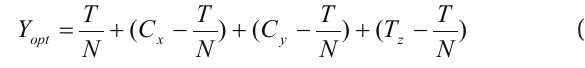
(3 4 ) matrix while the diameters of the 9